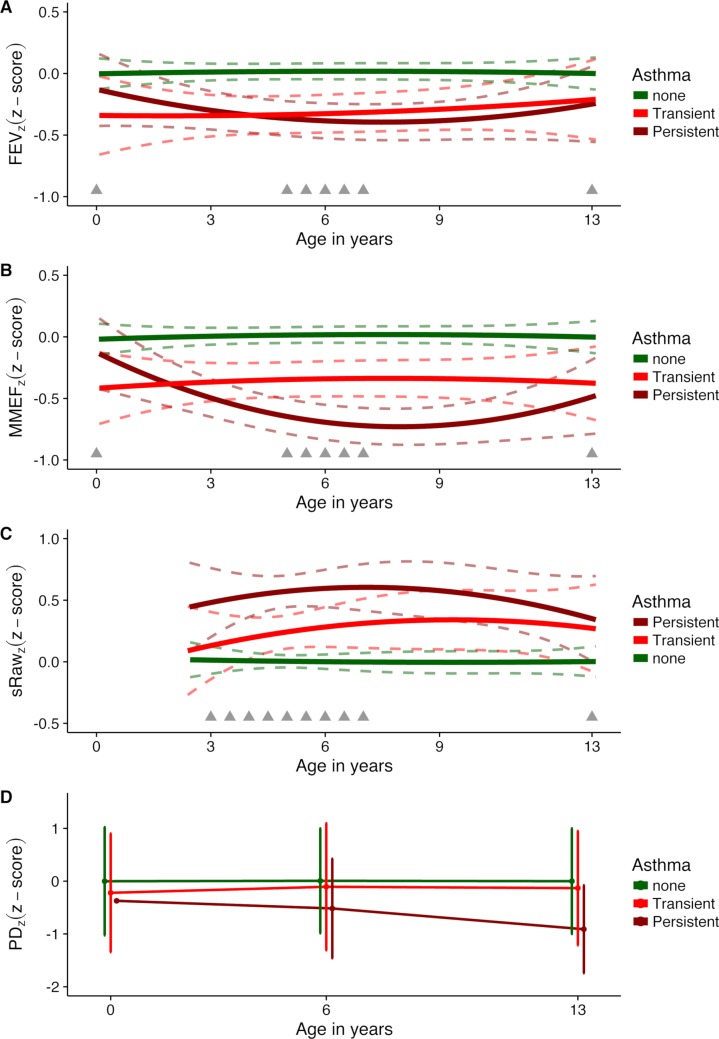
Development of z-scored measures of lung function and bronchial reactivity from 1 month to 13 years in children with transient asthma, children with persistent asthma, and children never developing asthma.z-Scores for (A) forced expiratory volume (FEVz), (B) maximal mid-expiratory flow (MMEFz), (C) specific airway resistance (sRawz), and (D) provocative dose of methacholine (PDz). Dashed lines represent 95% confidence intervals; grey triangles indicate timing of measurements.